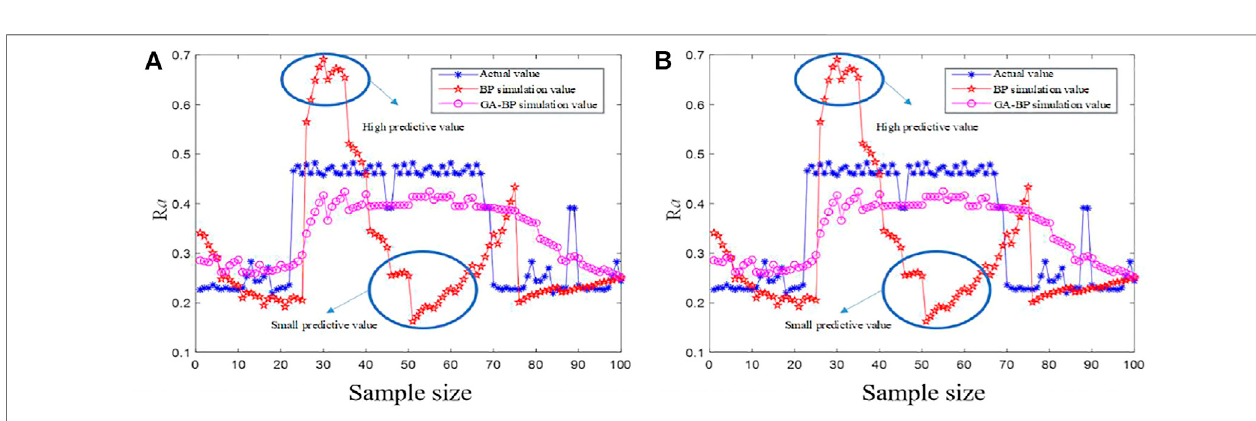
FIGURE 6 | Comparison of actual roughness and roughness predicted by different algorithms. (A) BP and GA-BP prediction results analysis. (B) BP and PSO-BP prediction results analysis.